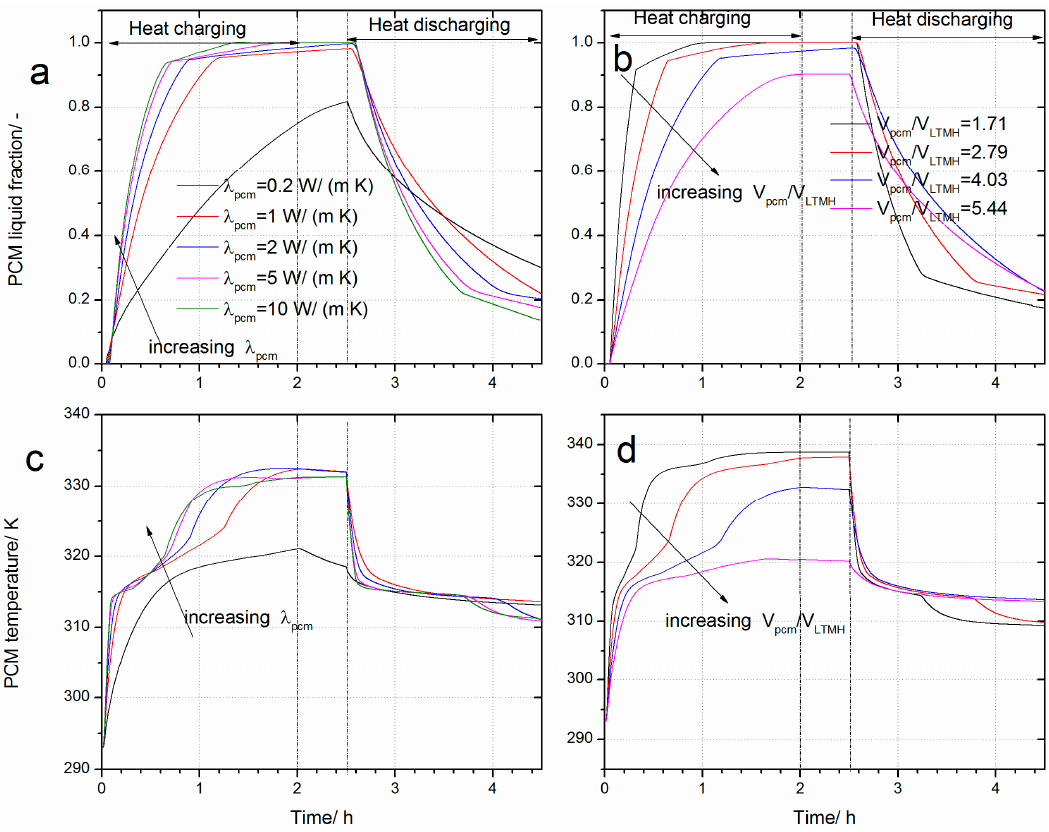
Figure 14. The influence of PCM thermophysical properties on the PCM temperature: ( a ) Heat capacity ( b ) the latent heat of fusion, ( c ) the PCM density, ( d ) the phase transition temperature range.